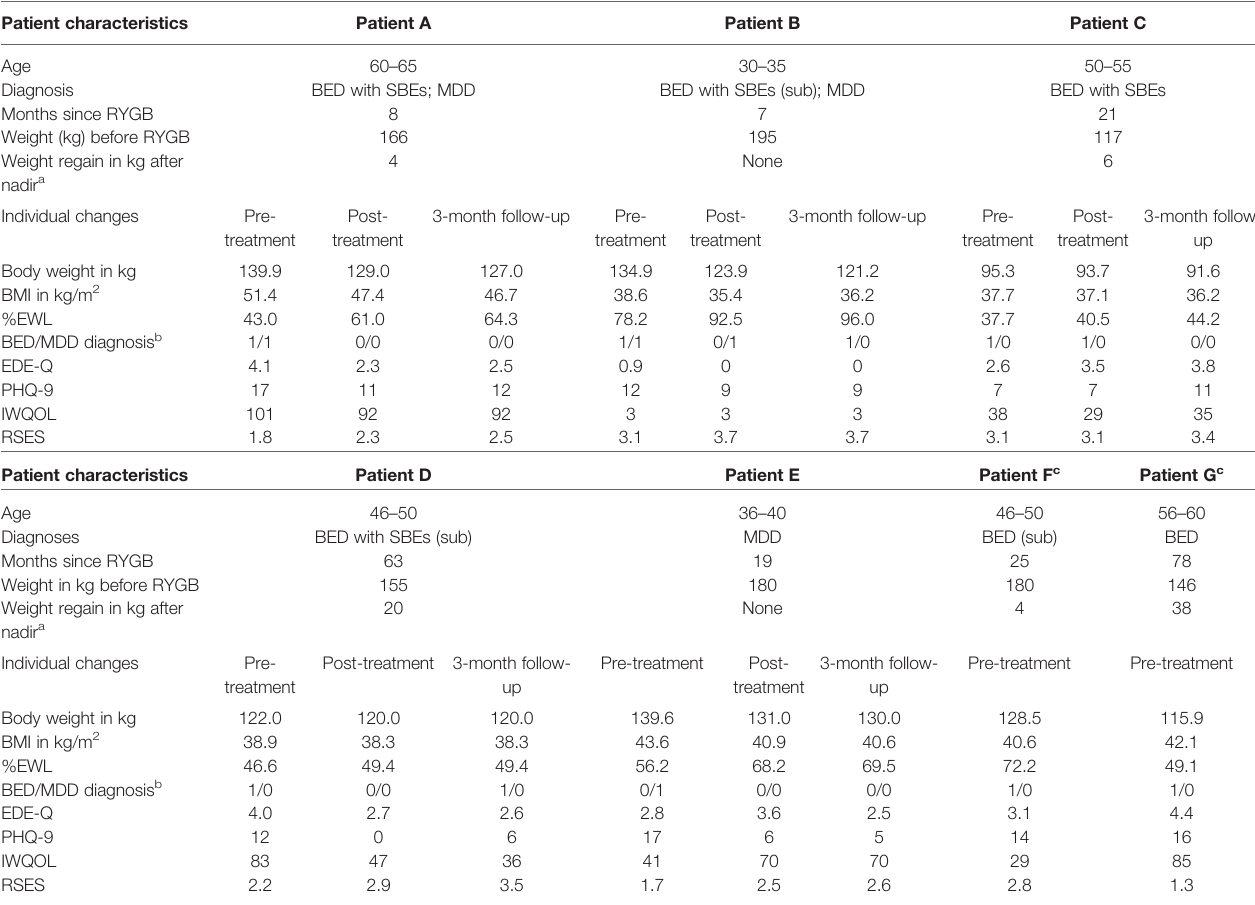
TABLE 1 | Patient characteristics and individual changes in clinical variables for pre-treatment, post-treatment, and 3-month follow-up assessments. Patient